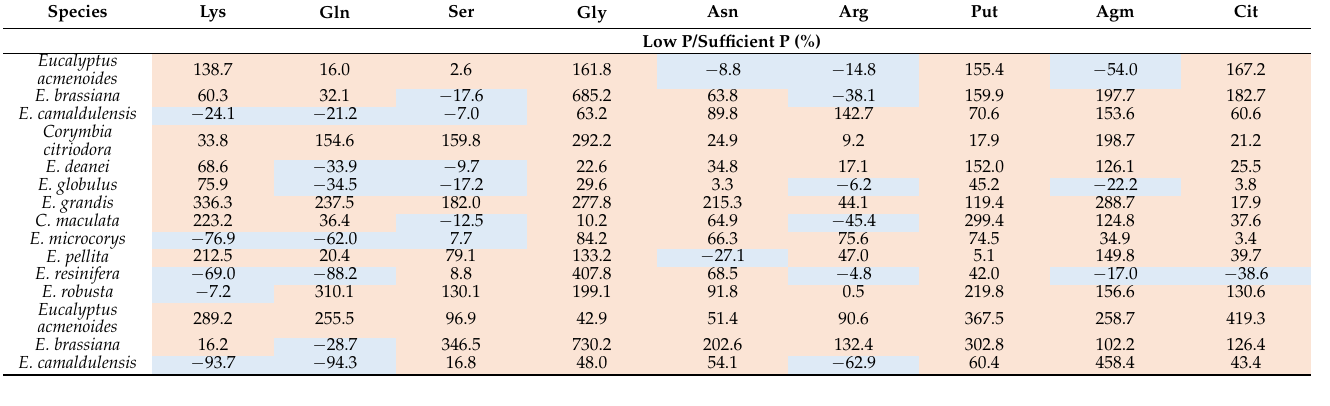
Table 2. Percentage of change between the amount of individual amino acids/polyamines exuded by roots under low and sufficient phosphorus concentrations in each eucalypt species. Blue-shaded cells indicate a decrease and orange-shaded cells indicate an increase in the percentage of change. nd = not found in the species. Figure 7. Amino acids and polyamines profile in root exudates of fifteen eucalypt species grown under low ( − ) and sufficient (+) phosphorus concentrations. Species abbreviations: A— E. acmenoides , B— E. brassiana, Ca— E. camaldulensis , Ci— C. citriodora , D— E. deanei , Gl— E. globulus , Gr— E. grandis , Ma— C. maculata , Mi— E. microcorys , P— E. pellita , Re— E. resinifera , Ro— E. robusta , T— E. tereticornis ,